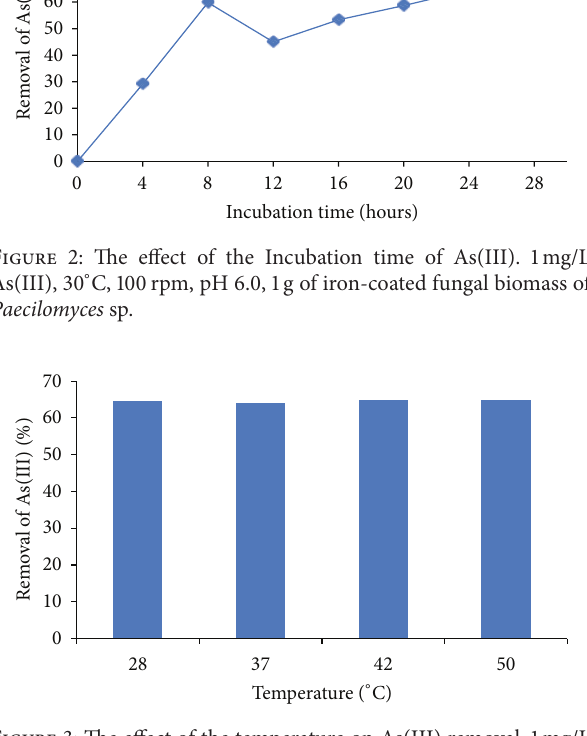
Figure 3: The effect of the temperature on As(III) removal. 1mg/L As(III), 100rpm, pH 6.0, 1g of iron-coated fungal biomass of Paecilomyces sp.